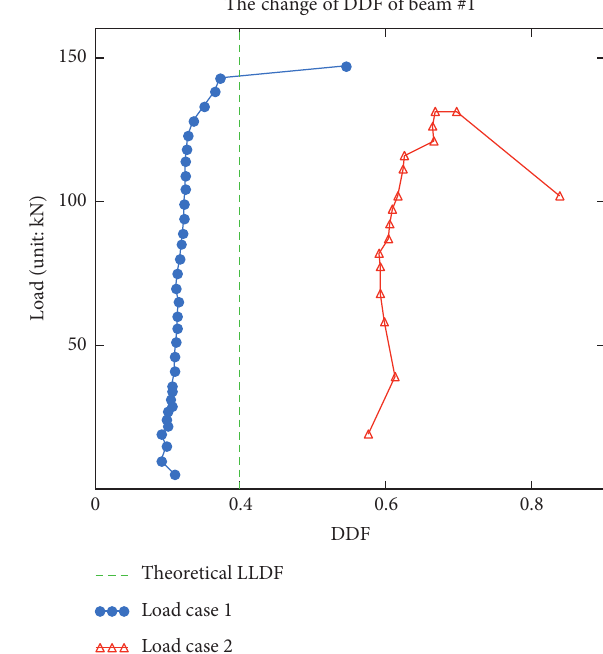
Figure 14: Change of deflection distribution factor with